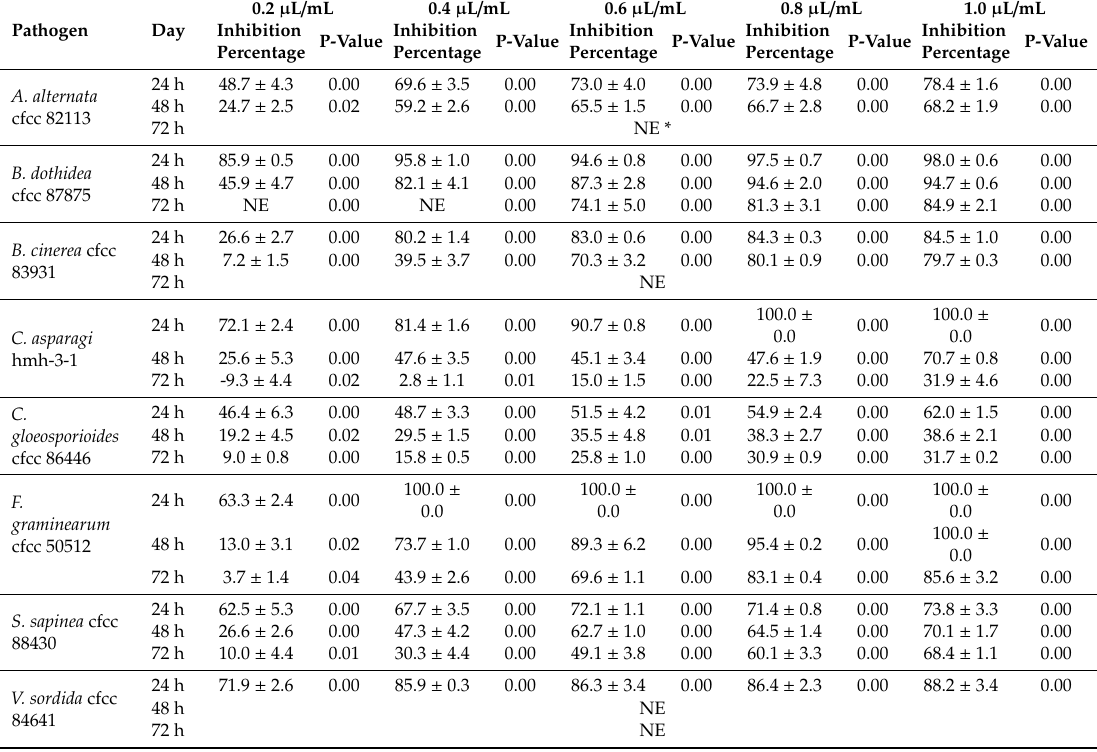
Table 4. E ff ects of γ -terpinene on fungal pathogens of plants determined by two-compartment Petri plate bioassay